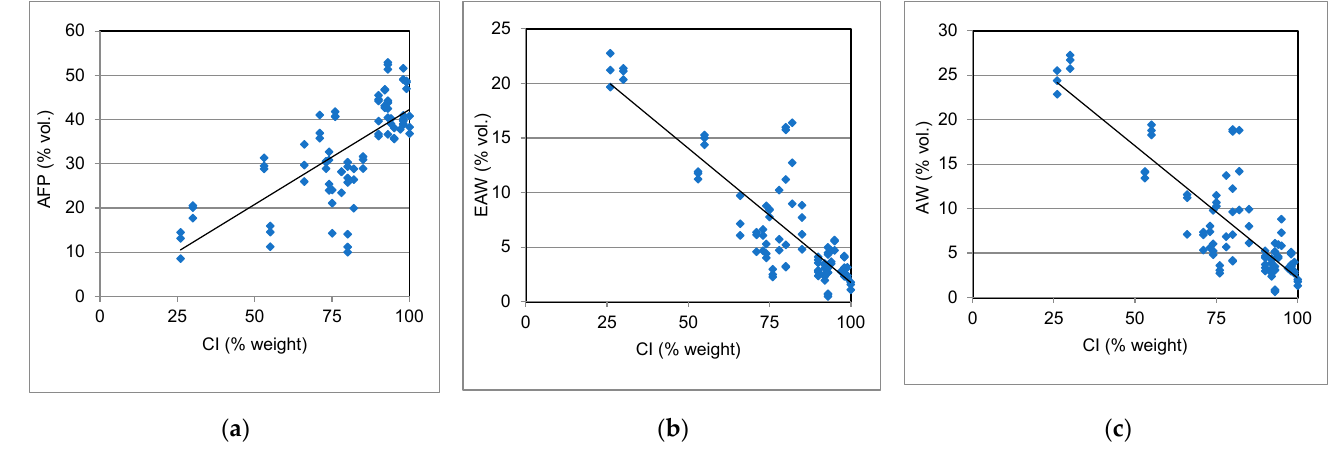
Figure 7. Linear regression: ( a ) AFP: CI; ( b ) EAW: CI; ( c ) AW: CI.